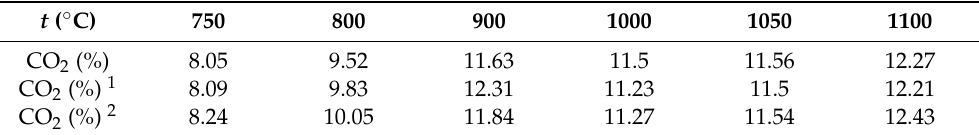
Table 4. Test data for CO 2 .